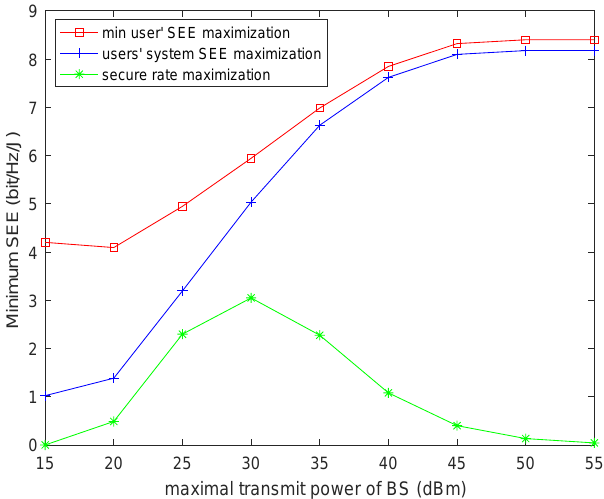
Figure 2. Minimum SEE for different BS transmit